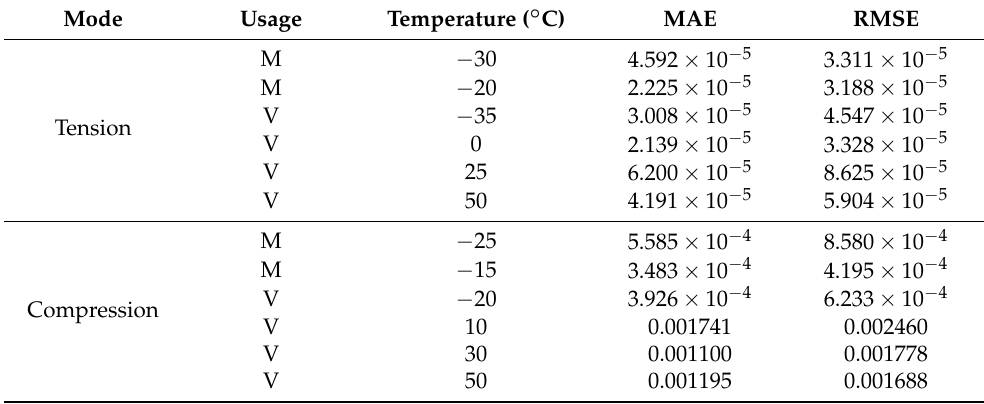
Figure 13. Prediction results of the test data under tension. ( a , b ) modeling data; ( c – f ) validation data. Table 3. Model prediction performance on test